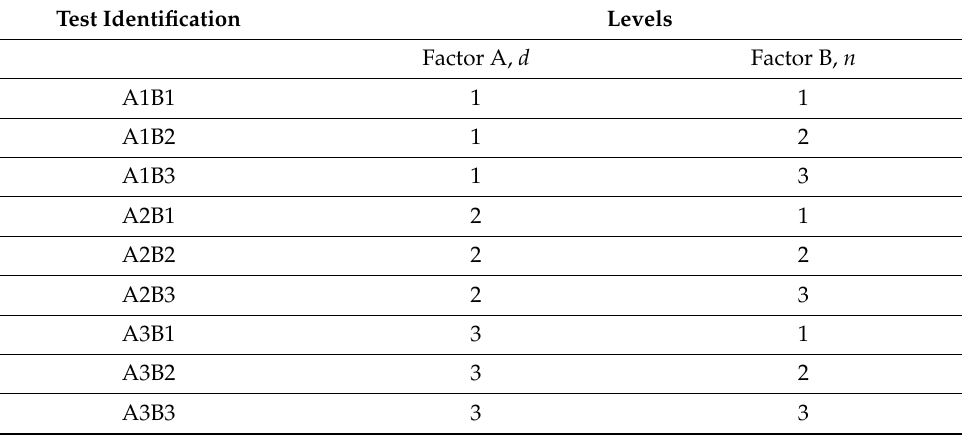
Table 2. Multilevel factorial design considered to assess the influence of the beam diameter (Factor A, d ) and the cell number (Factor B, n